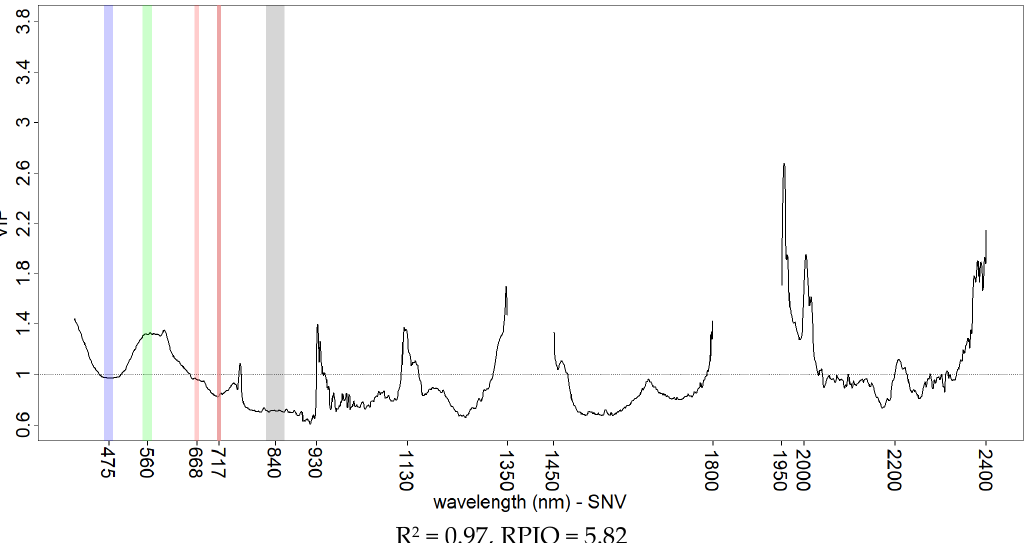
Figure 11. VIP scores of KE PLSR models from hyperspectral data using the SNV of the full vis-NIR-SWIR spectral range. Goodness of fit is reported with R 2 and RPIQ. The multispectral broad-bands of the Rededge-M camera model are shown for comparison.